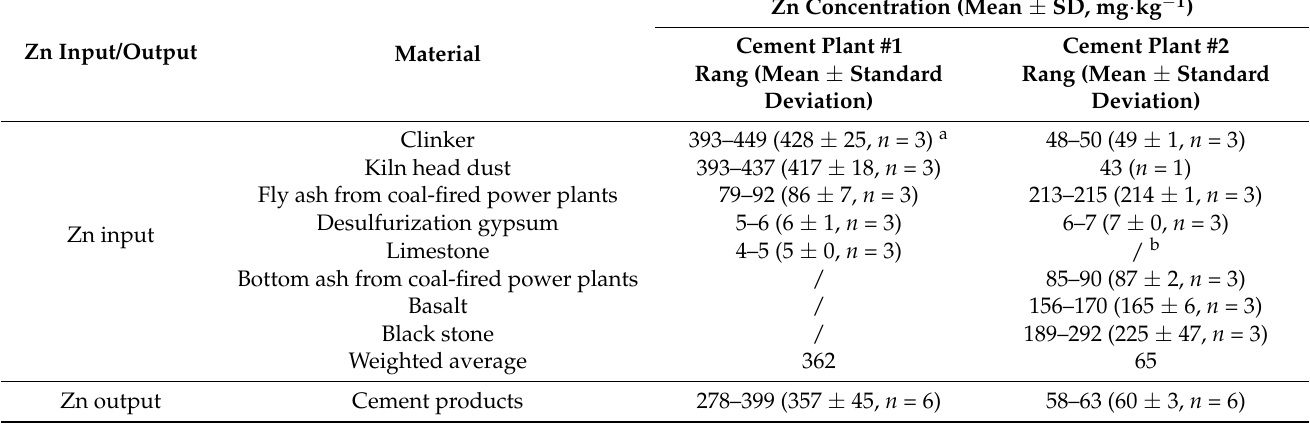
Table A2. Concentration of Zn in different input and output materials during the clinker-to-cement production process.